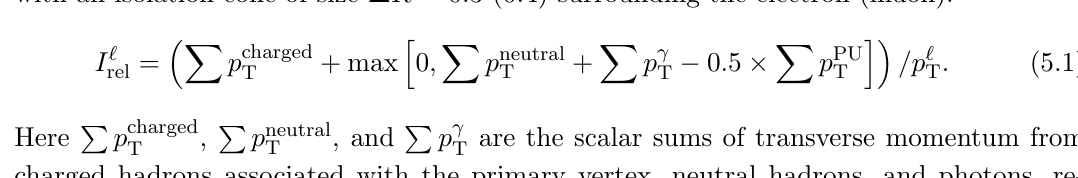
Figure 3 . The background-only (cid:12)t to data is performed, for low- p miss categories, with the sum of a power law (dashed black) (cid:12)t function to describe the nonresonant contribution, and a resonant shape (dashed red), taken from simulation, to take into account the SM h ! (cid:13)(cid:13) contribution. The SM h contribution is (cid:12)xed to the theoretical prediction in the statistical analysis. The sum of the nonresonant and resonant shapes (solid blue) is used to estimate the total background in this